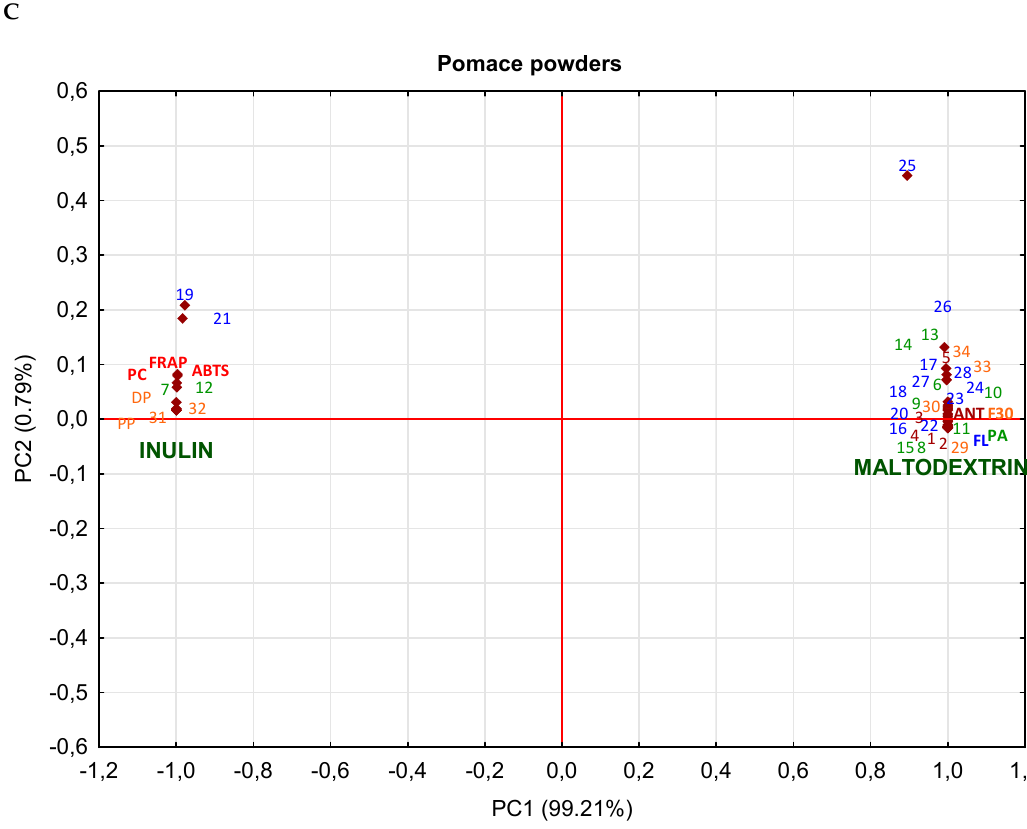
Figure 1. Principal component analysis (PCA) of the impact of type of carrier to phytochemical parameter in fruit ( A ), juice ( B ), pomace ( C ) powders. Abbreviations: ANT—sum of anthocyanins; FL—